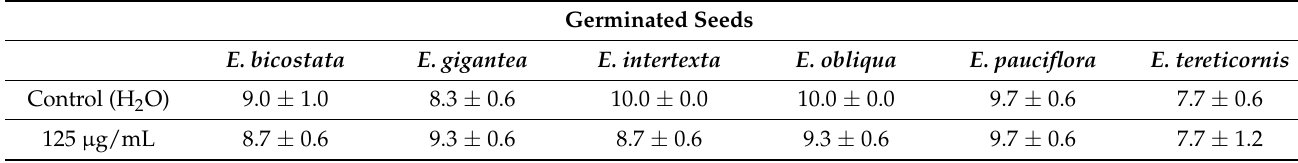
Table 4. Phytotoxic activity of the EOs on L. multiflorum